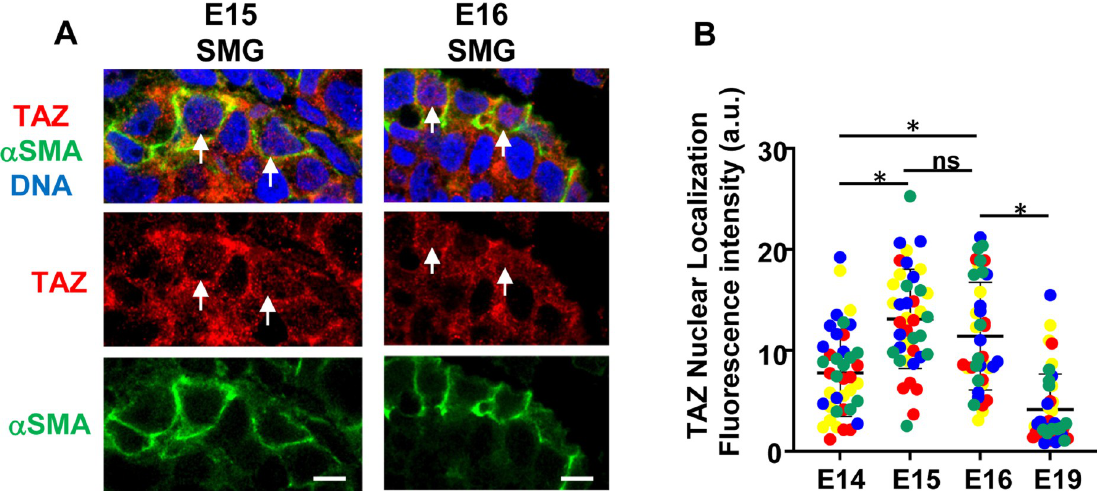
Fig 6. Expression of α -SMA expression and TAZ in E15 and E16 SMGs. (A) Representative confocal images of E15 and E16 embryonic SMGs immunostained for TAZ, α -SMA, and DNA. Images are a single Z-slice acquired at 63X representative of four SMGs. White arrows represent cells with α -SMA expression and with TAZ co-localization with the nuclear marker DRAQ5. White arrowhead indicates a representative cell lacking α -SMA expression and also the lack of TAZ co-localization with the nuclear marker DRAQ5. Images are single z-slices acquired at 63x. Size bar, 5 μ m. (B) The expression of TAZ colocalized with nuclei at E14, E15, E16 and E19 was measured using ImageJ. Only cells on the basal surface of developing buds were analyzed. Plotted is the integrated fluorescence intensity of nuclear TAZ ± s.d for individual nuclei measured from four single slice confocal images acquired at 63X from two glands for each timepoint. a. u = arbitrary units. Measurements taken from each individual image are shown different colors. � p < 0.05 using one-way ANOVA followed by Tukey Post-hoc test. ns = not